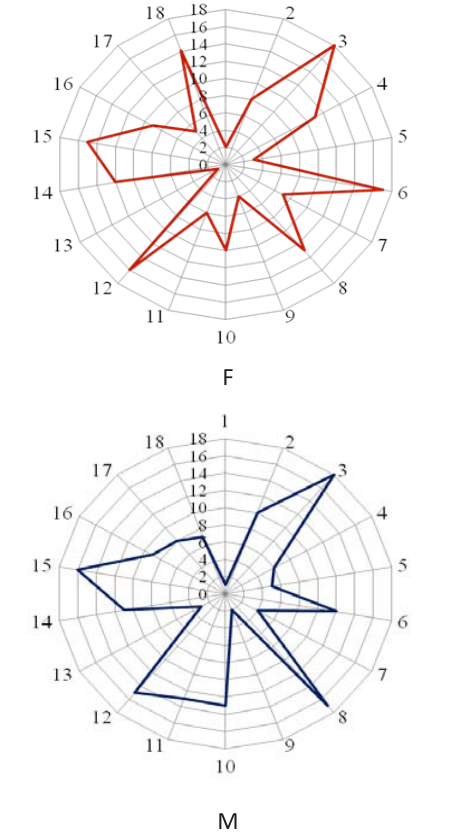
Fig. 1. Hierarchy of terminal values of students (males,